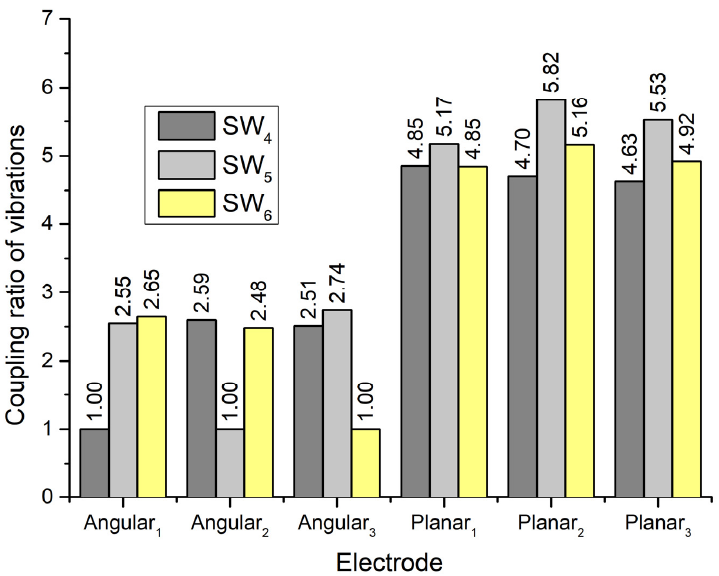
Figure 11. Vibration coupling ratios when electrodes Angular 1 –Angular 3 are excited.